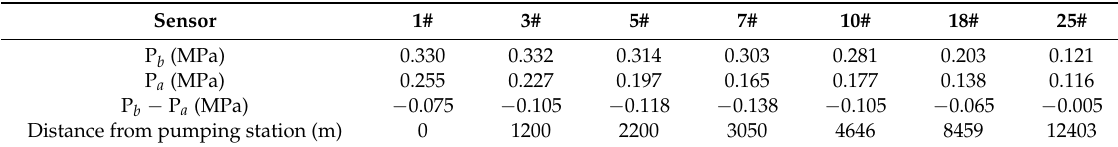
Table 2. Pressure change before and after the burst.